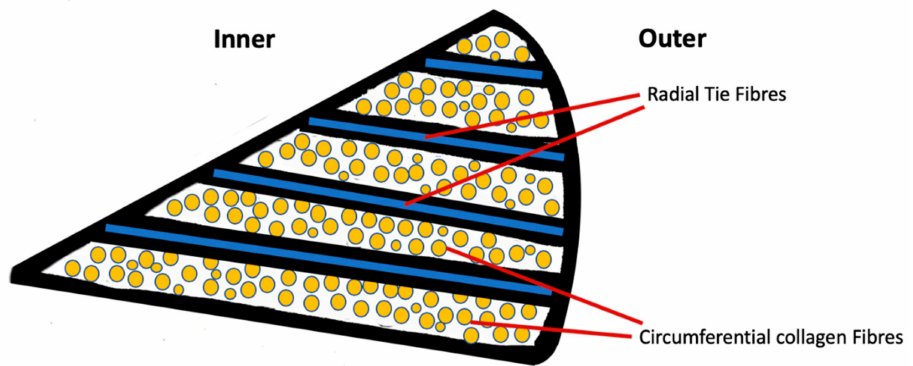
Figure 1. Schematic diagram of the axial section at the level of the tibial plateau depicting the anatomy, attachments, and relations of the menisci. MM, Medial Meniscus; PCL, Posterior Cruciate Ligament; LM, Lateral Meniscus; ACL, Anterior Cruciate Ligament.